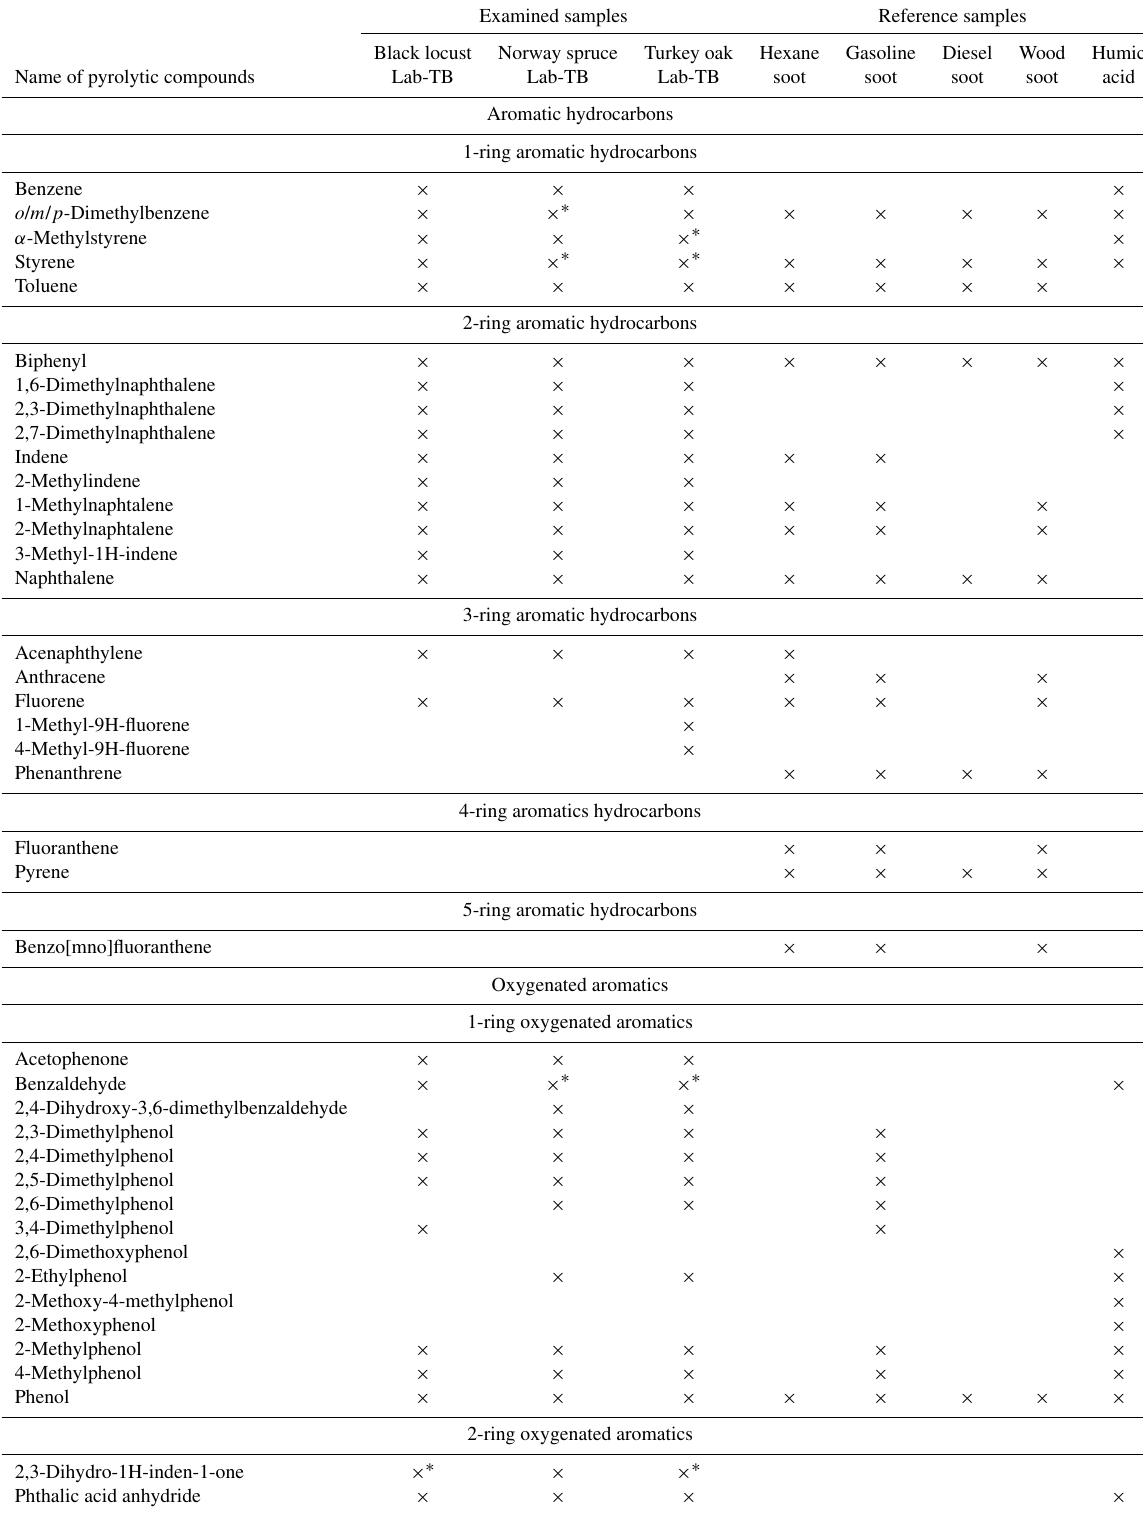
Table 2. Identified components from Py-GC-MS chromatogram of Lab-TBs produced from different wood species, compared with the identified pyrolytic products of hexane, gasoline, diesel, and wood soot (Song and Peng, 2010), and humic acid extracted from particulate matter (Subbalakshmi et al.,